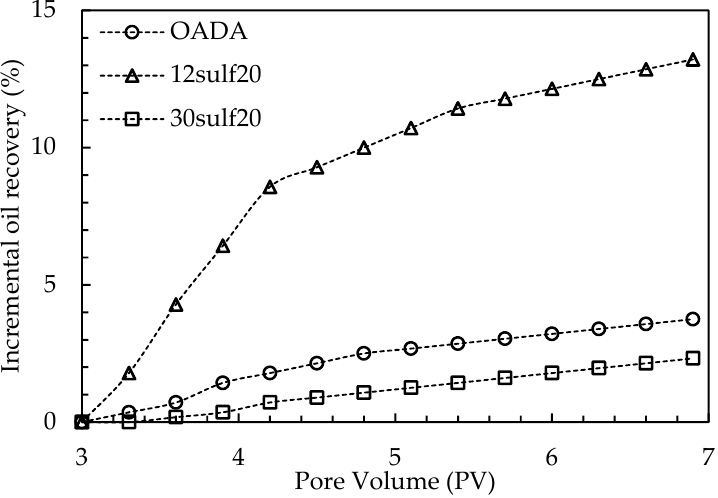
Figure 17. Incremental oil recovery as function of pore volumes after the secondary oil recovery.